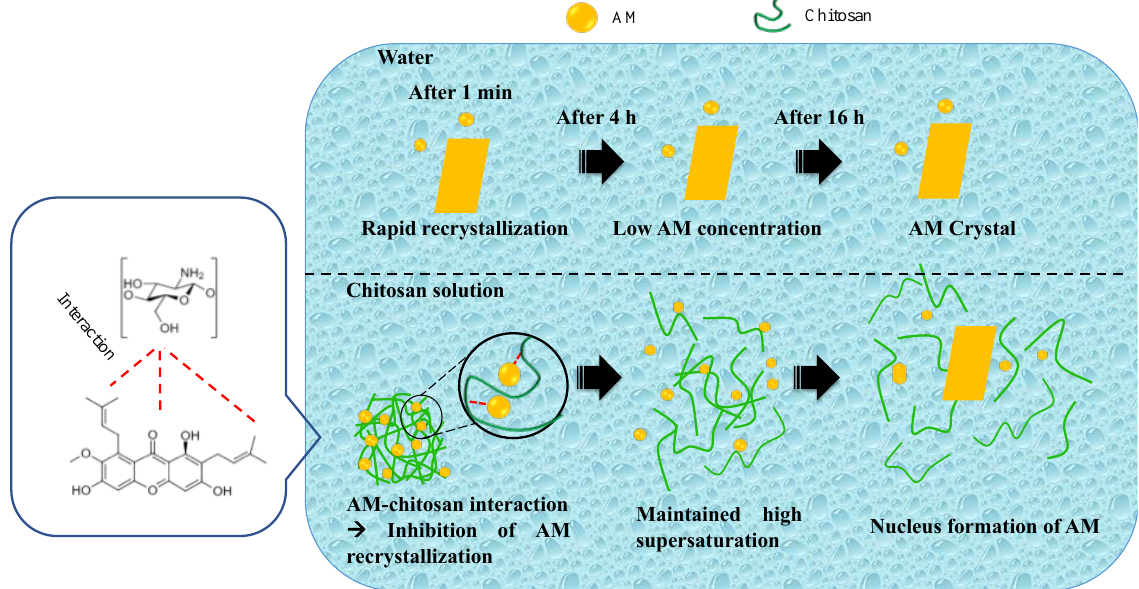
Figure 10. Schematic illustration of crystallization inhibition of AM from the supersaturated solution.